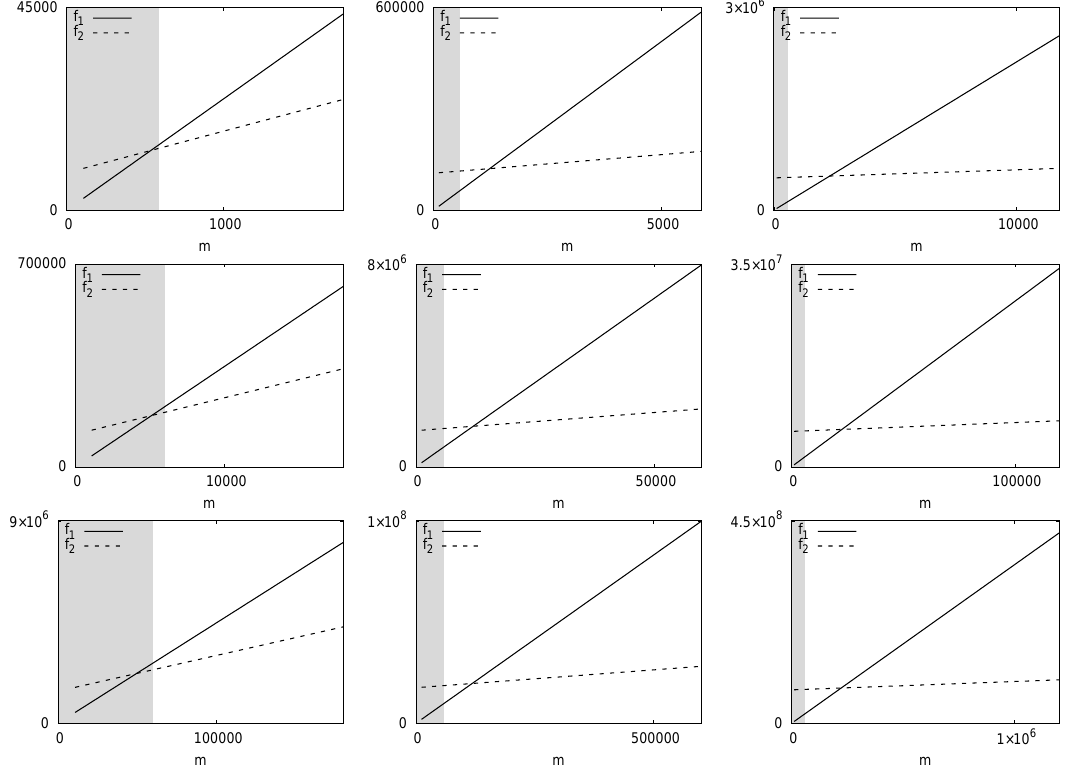
Figure 6. Comparison of growth rates f 1 and f 2 with regards to the number of edges m . Rows show n -values of 100, 1000 and 10,000 respectively; columns consider values c − max = c + max of 3, 10, and 20